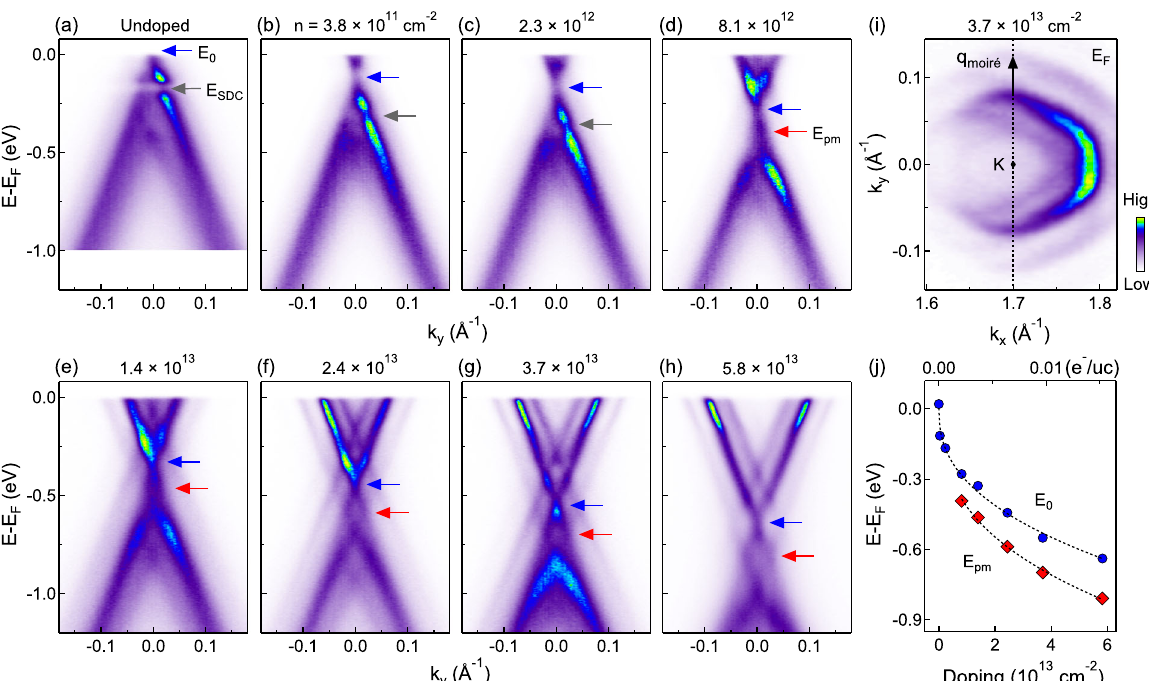
Fig. 2 Formation of plasmaron bands upon doping in a 0 ∘ aligned graphene/h-BN. a – h Evolution of the electronic structure through the K point (indicated by black dotted line in i ) upon electron doping. E 0 , E SDC and E pm indicate the Dirac point energy, second-generation Dirac point energy, and plasmaron crossing energy respectively. i Fermi surface map at doping level corresponding to data shown in g . j Dirac point energy E 0 and plasmaron crossing energy E pm as a function of electron doping. Black broken curves are guides to the eyes.